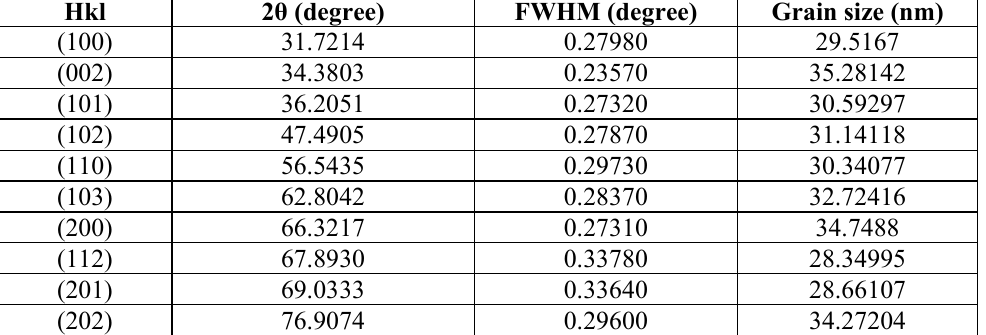
Fig.2: XRD patterns of ZnO nanostructures synthesised using 2.5 M sodium hydroxide concentration and annealed at (300 °C, 400 °C and 500 °C ) Table 1: The X-ray diffraction parameter and grain size of ZnO nanostructures prepared using 2.5 M NaOH.